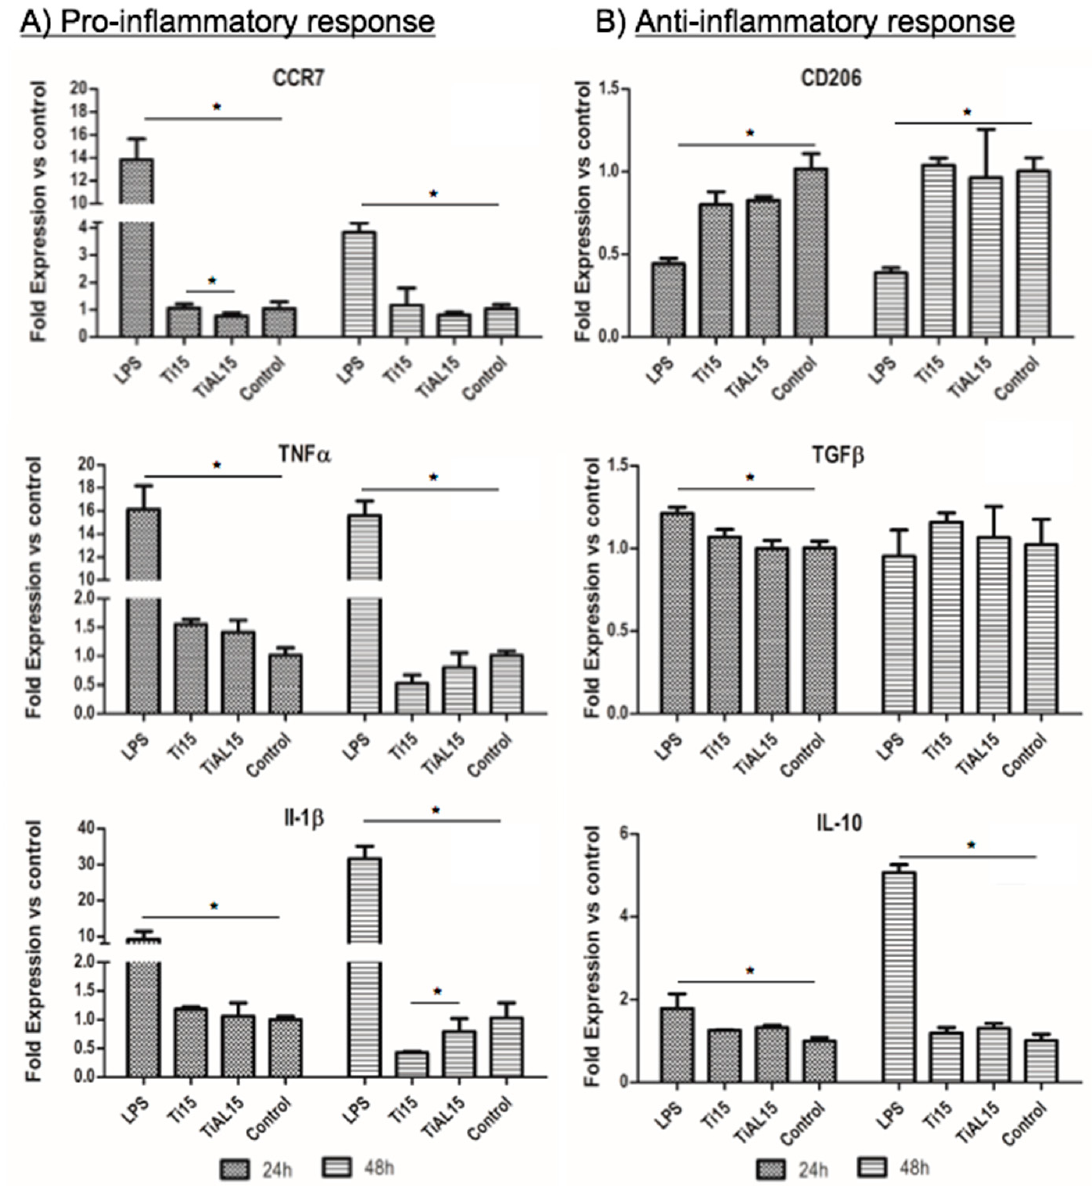
Figure 9. RNA analysis of the inflammatory response in THP–1 cells for pro–inflammatory ( A ) and anti–inflammatory ( B ) markers. Cells cultured with extracts of microparticles of Titanium (Ti15) and the alloy of titanium, aluminium and vanadium Ti6Al4V (TiAL15). * p < 0.05 .